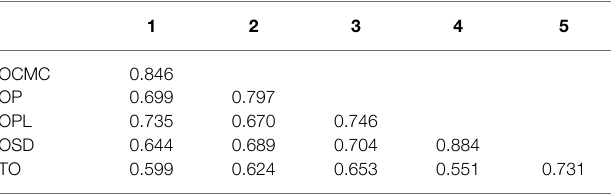
TABLE 2 | Discriminant